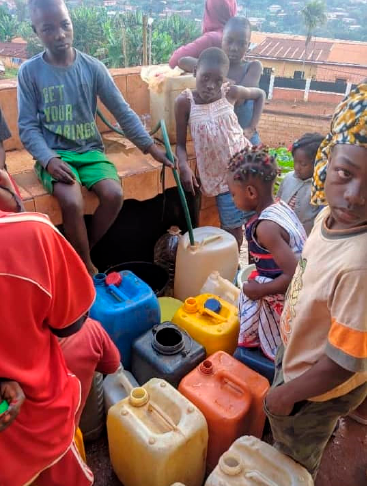
Figure 5. A crowded protected source in Mba on 6 October 2021. Photograph taken by Junior Fangang-Fanseu, October 2021.